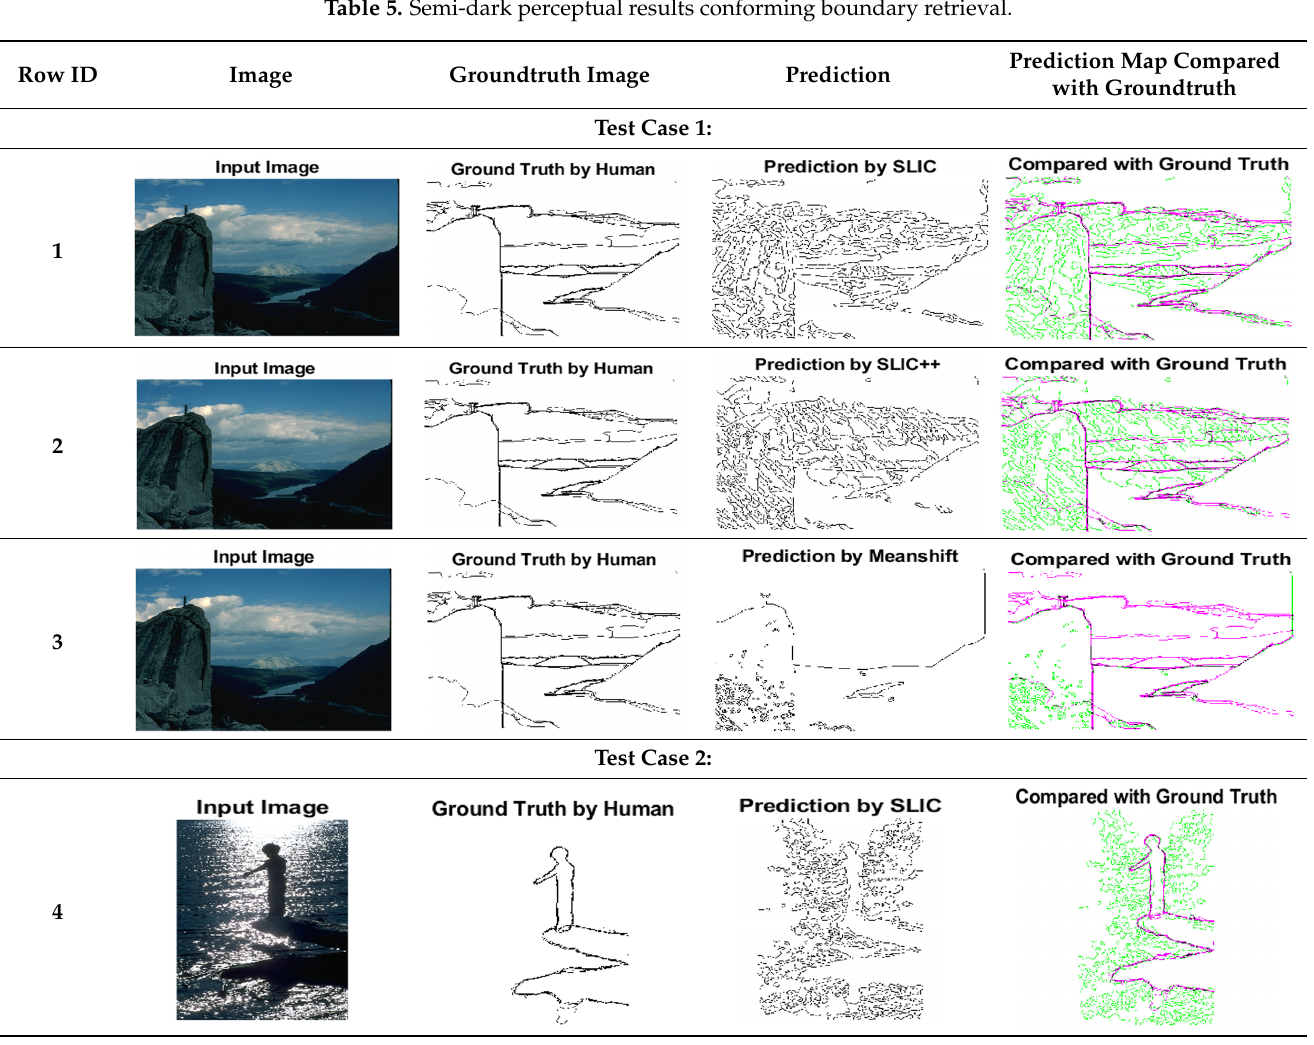
Table 5. Semi-dark perceptual results conforming boundary retrieval.